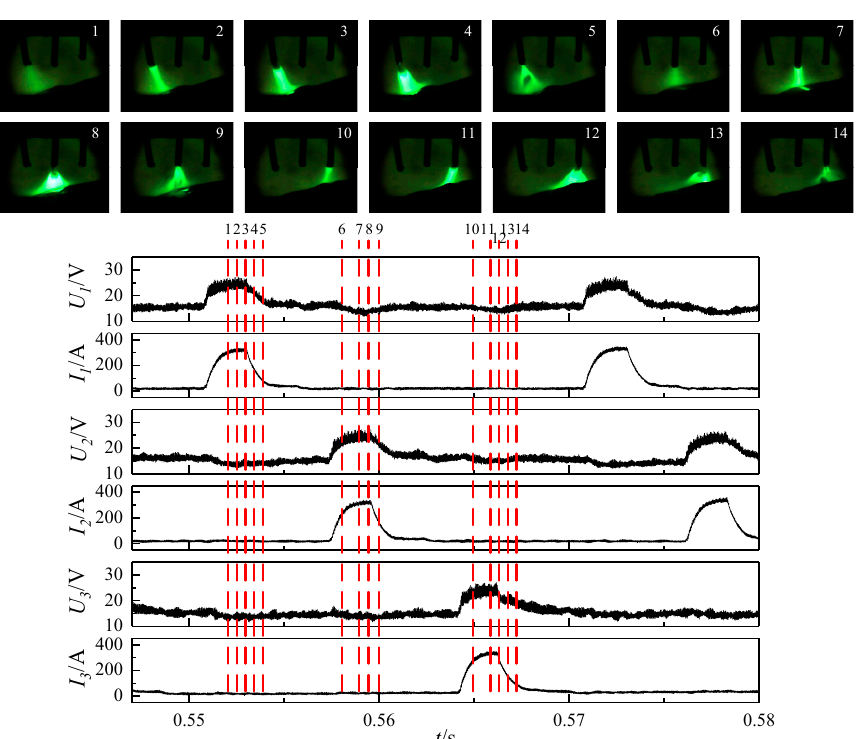
Figure 7. Welding arc and droplet transfer in the double-pulse, triple-wire welding process (double- pulse frequency f d = 3 Hz).